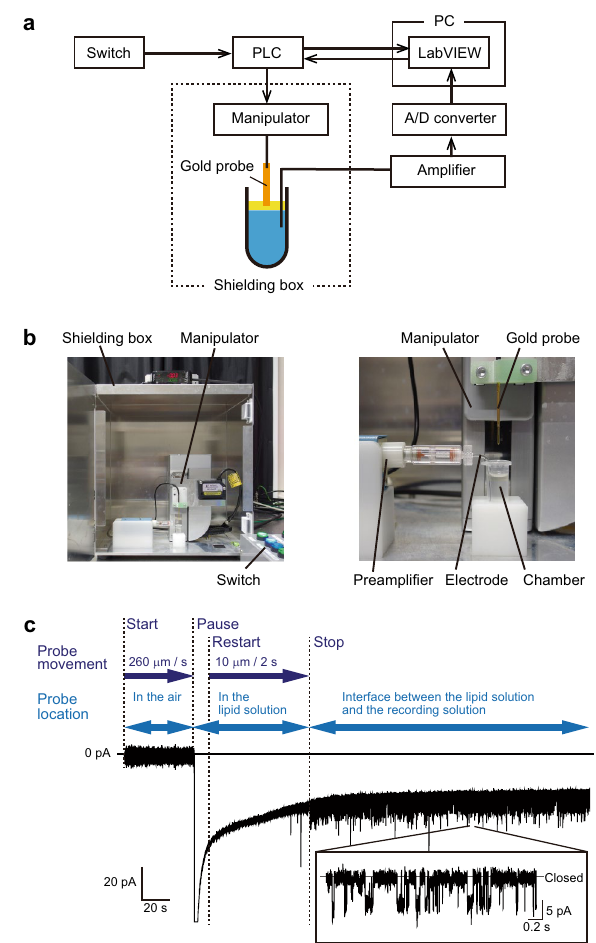
Figure 5. The automated system for the measurement of ion channel currents. (a) Flow diagram of the automated measurement system using the gold probe. (b) Photograph of the measurement system and the shielding box that contains it (left) and blow-up of the system (right). (c) Typical current trace automatically measured using the system at − 60 mV. The system moved the probe until channel currents were automatically